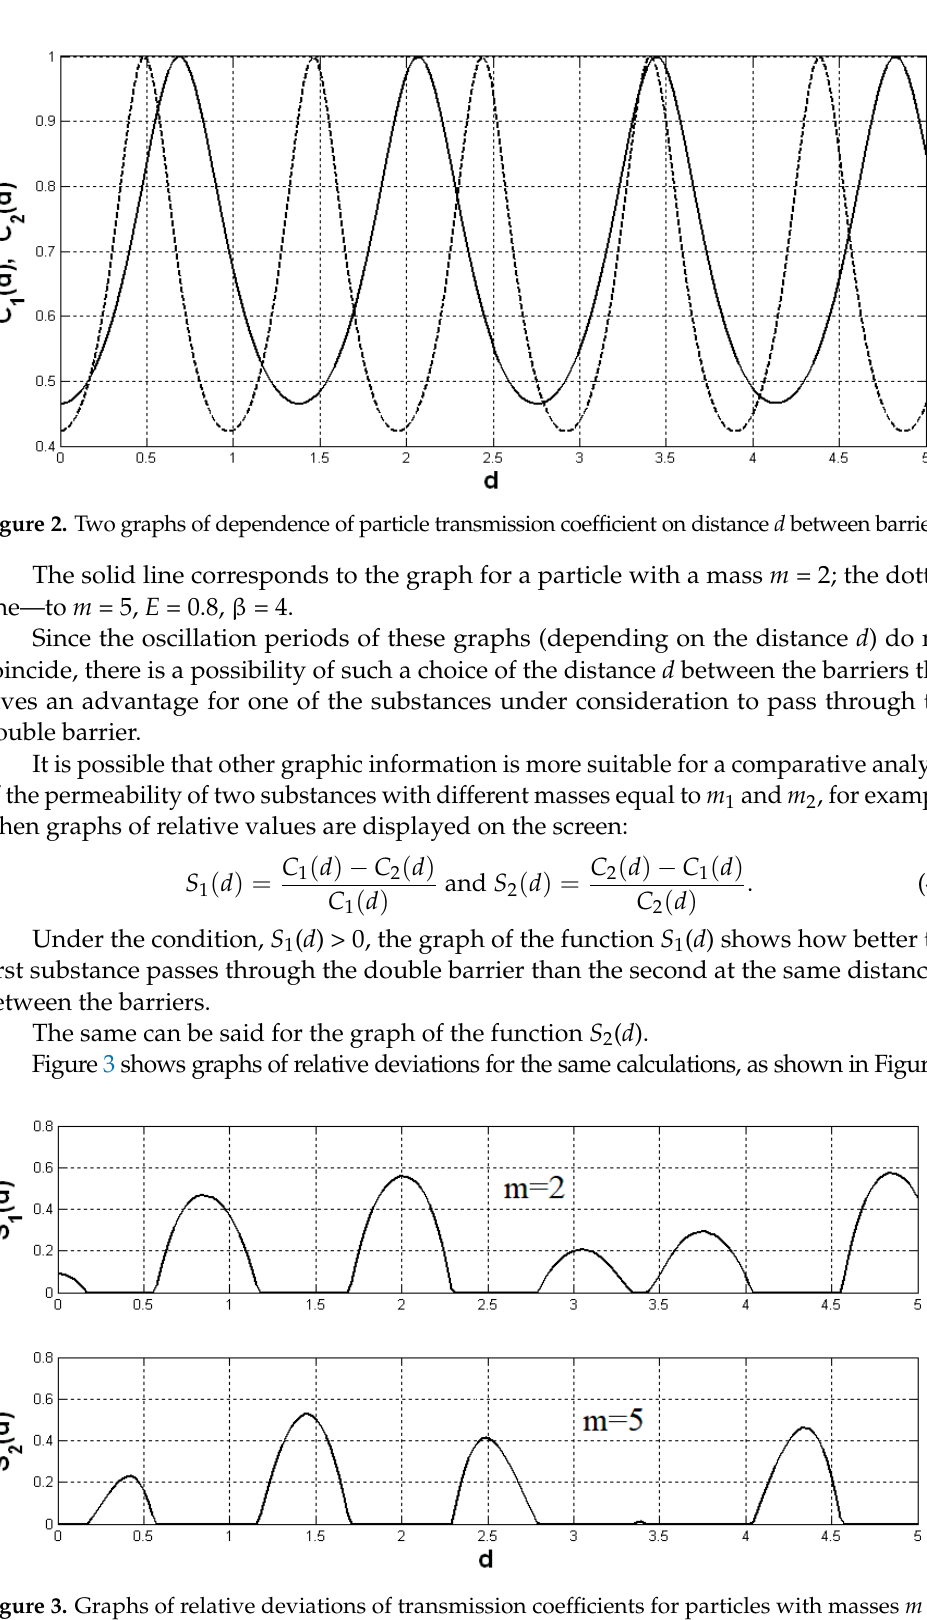
Figure 3. Graphs of relative deviations of transmission coefficients for particles with masses m = 2 and m = 5.